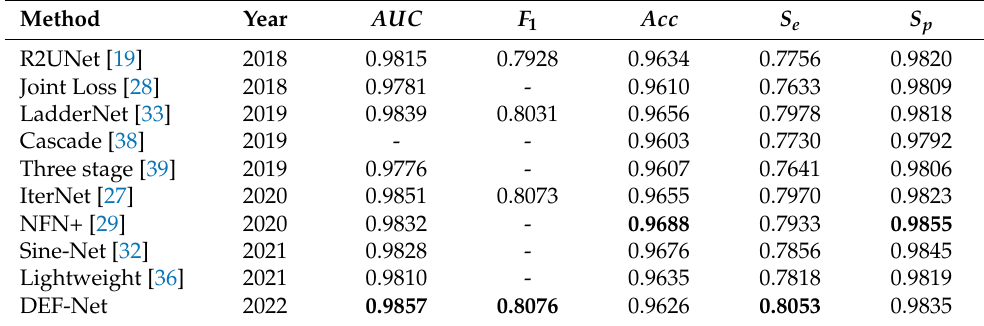
Table 5. Comparison results with advanced methods on CHASE_DB1 dataset.